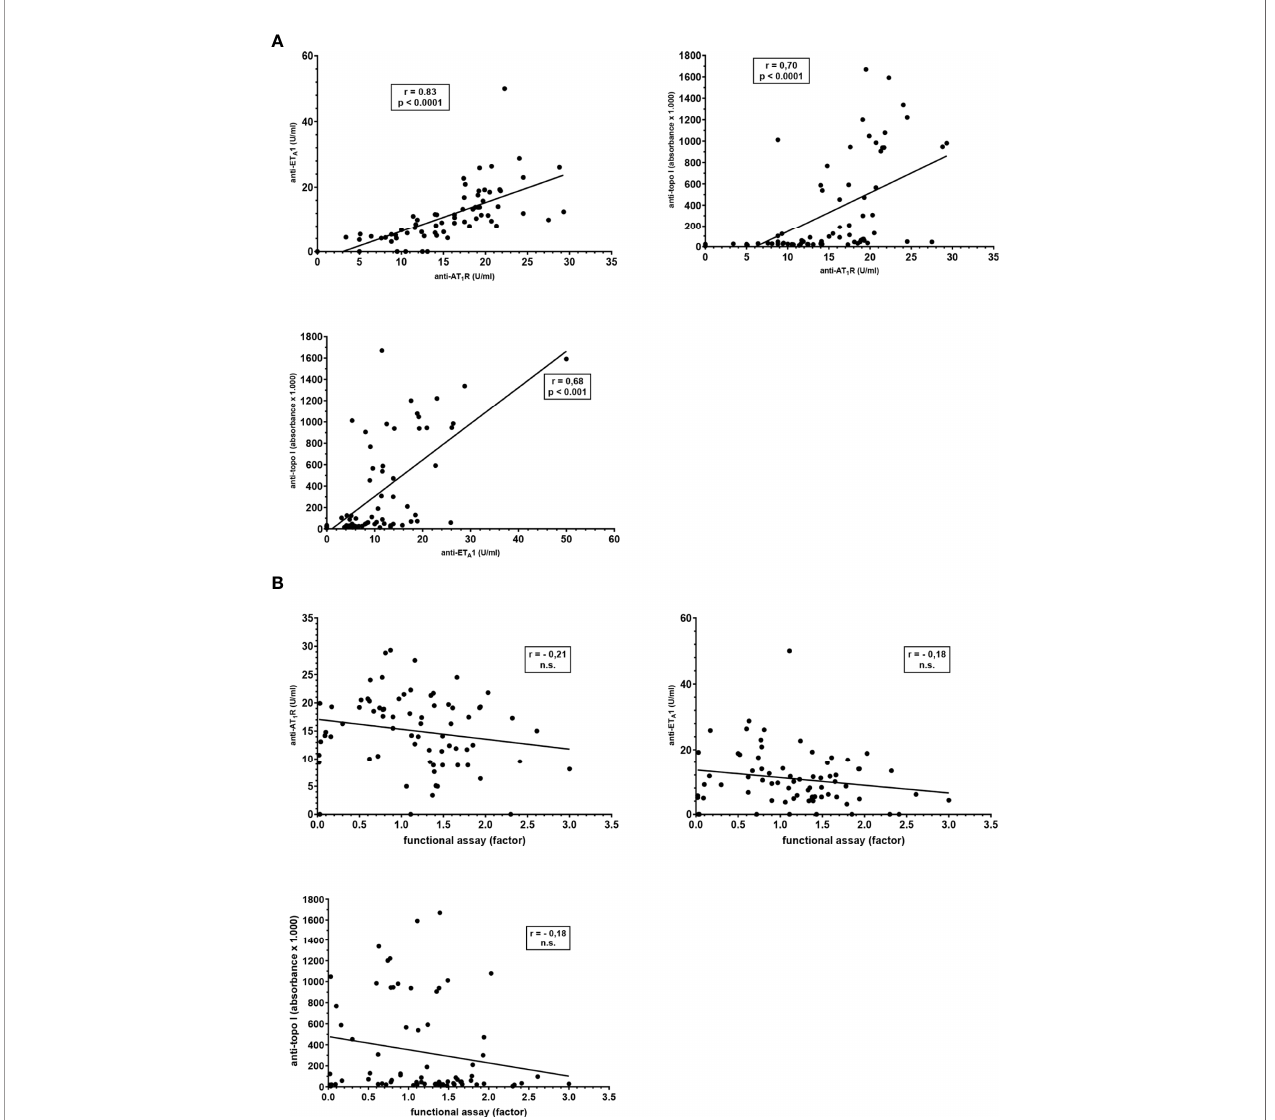
FIGURE 4 | Correlation between reactivities towards AT 1 R, ET A 1, and topo-I measured by different methods in sera from 73 patients with SSc. (A) Comparison of the antibody reactivities towards AT 1 R, ET A 1, and topo-I measured by ELISA. (B) Comparison of the anti-AT1R reactivities determined by the functional luminometric assay and anti-AT 1 R-, -ET A 1-, and -topo-I-antibodies determined by ELISA. Slopes, Spearman r correlations and signi fi cance levels are